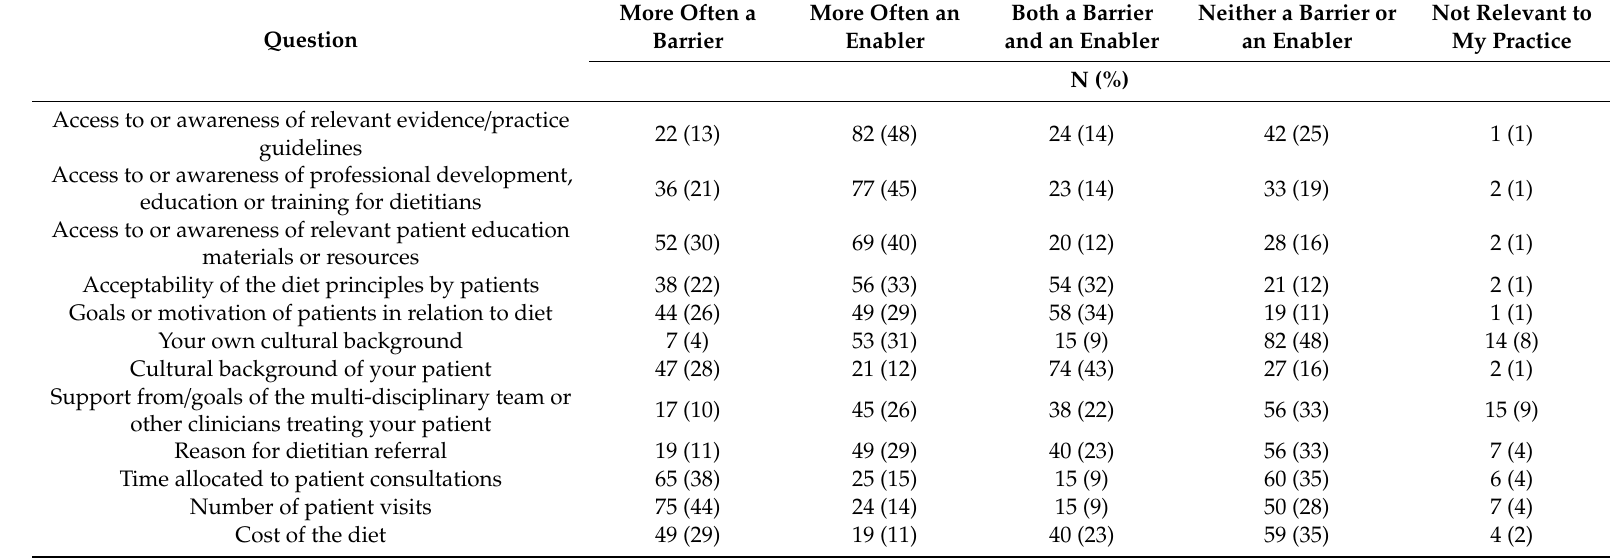
Table 4. Barriers and enablers to whether participants recommend the MDP to their relevant patients ( n = 171). Question